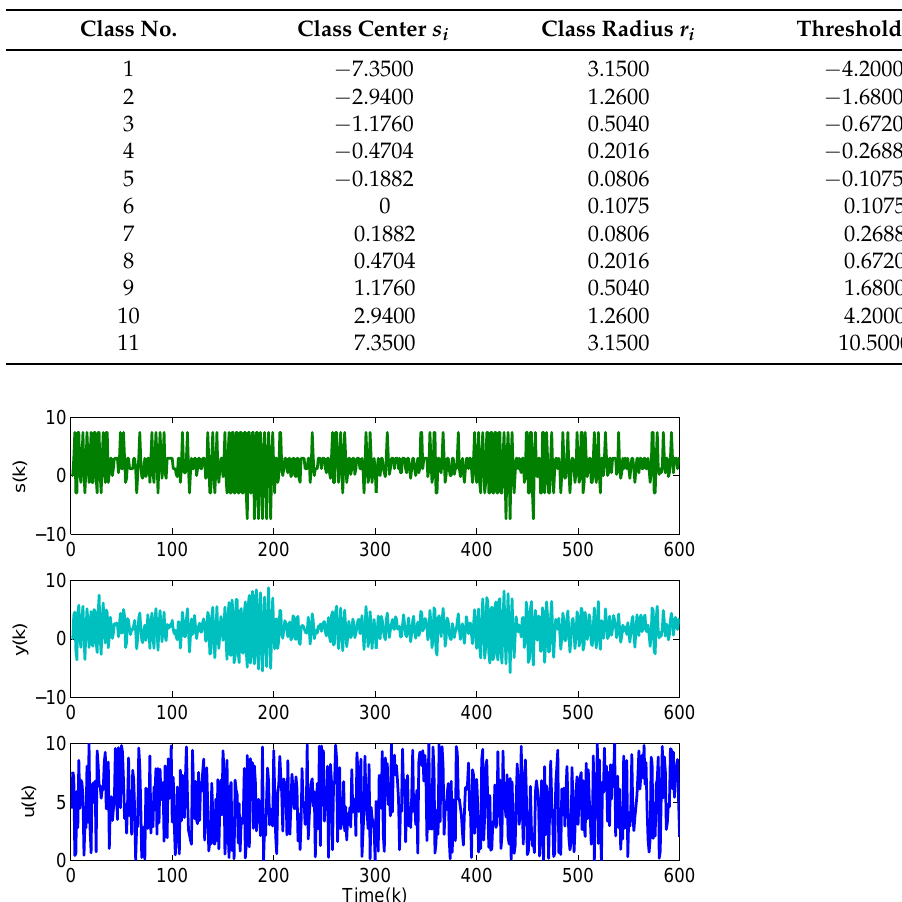
Table 1. Property values of pattern class.